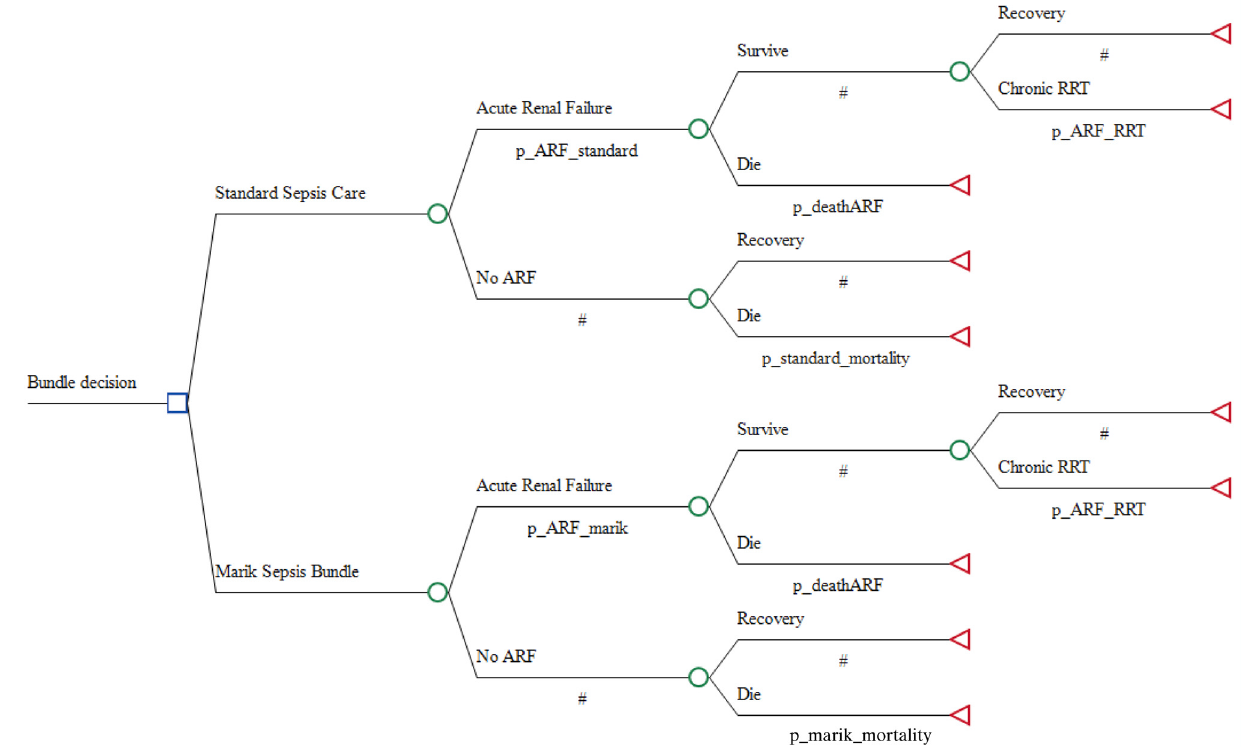
Figure 1. Sepsis decision tree model using TreeAge Pro 2017.